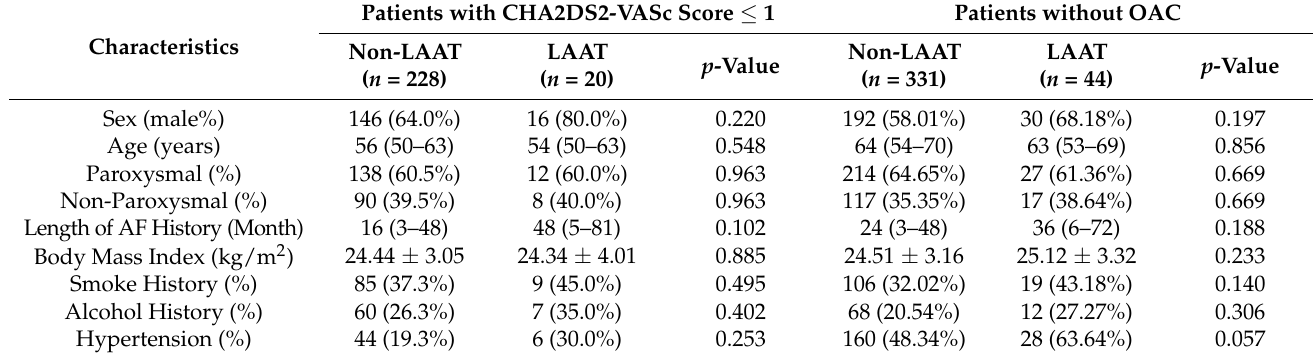
Table 2. Baseline characteristics of subgroups with CHA2DS2-VASc score ≤ 1 (female excluded) and patients without